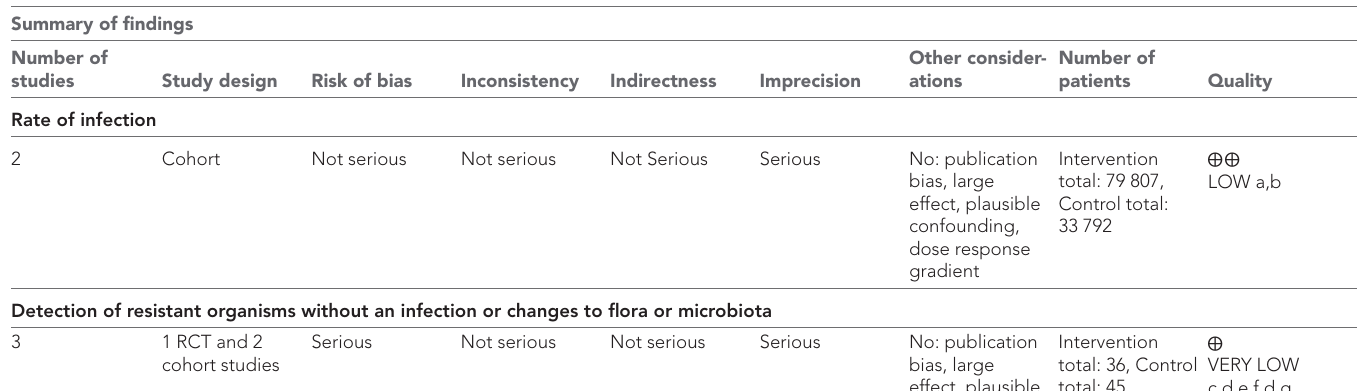
Table 3 Summary of findings (GRADE assessment of quality of